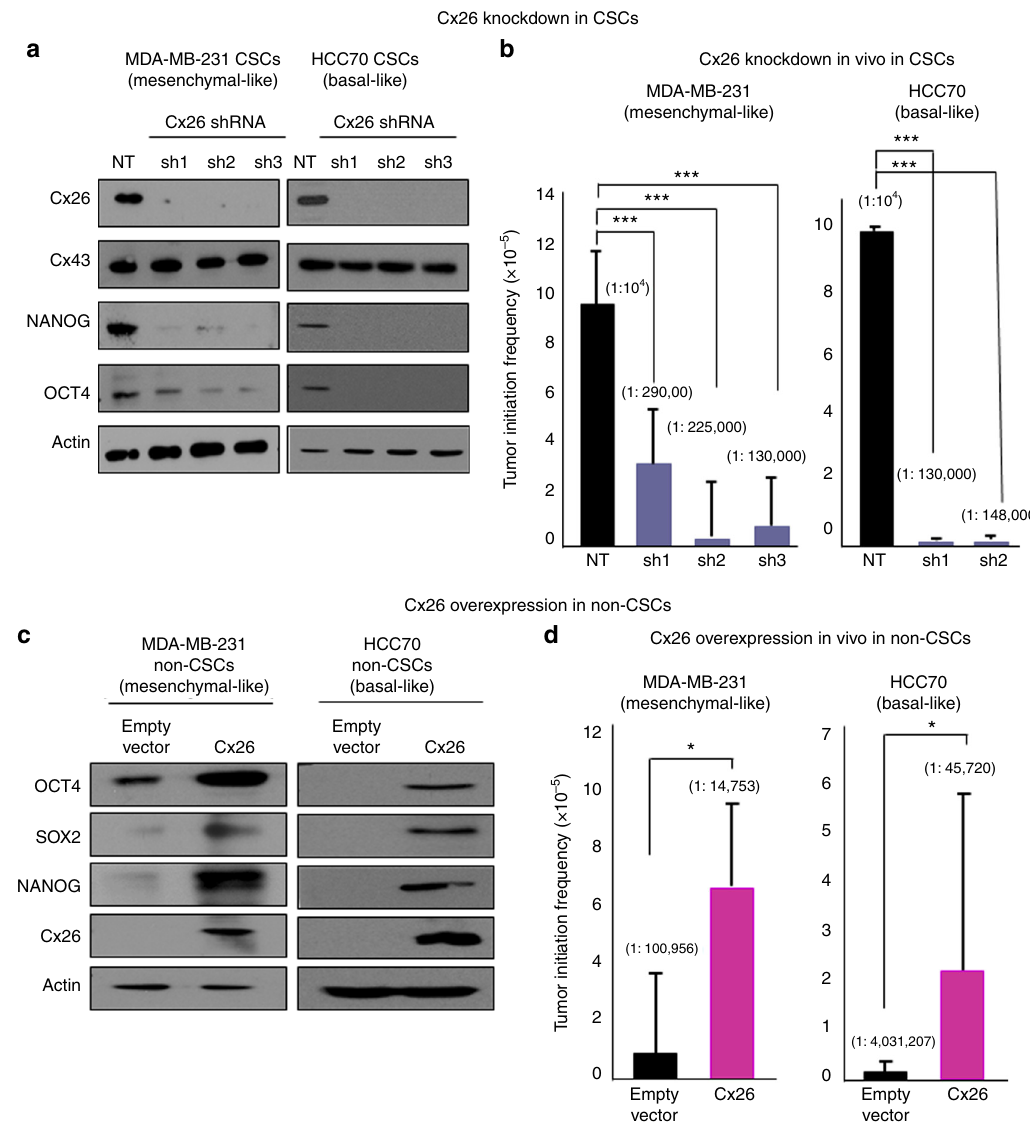
Fig. 2 Cx26 is necessary and suf fi cient for the maintenance of self-renewal, in vivo tumor initiation, and NANOG expression. a Cell lysates from MDA-MB- 231 and HCC70 CSCs silenced using three Cx26 shRNA constructs (sh1, sh2, and sh3) and a non-targeting shRNA (NT) control were probed with Cx26, Cx43, NANOG, and OCT4 antibodies. Actin was used as a loading control. b In vivo tumor initiation studies were performed in Cx26 -silenced MDA-MB- 231 and HCC70 CSCs with at least four mice per group, and the p value was calculated using a log-rank analysis. The graphs show the estimates of stem cell frequencies of NT control compared with the Cx26 shRNA silencing constructs and their corresponding p values. c MDA-MB-231 and HCC70 non- CSCs containing Cx26 overexpression vector or empty vector were probed with anti-Cx26, NANOG, OCT4, and SOX2 antibodies. Actin was used as a loading control. d In vivo tumor initiation studies were performed comparing the empty vector group with the Cx26 overexpression group, and the p value was calculated using a log-rank analysis. The graphs show the estimates of stem cell frequencies with the corresponding p values for the empty vector compared with Cx26 overexpression in MDA-MB-231 and HCC70 non-CSCs. (* p < 0.05, *** p < 0.001). All the error bars indicate the range between the